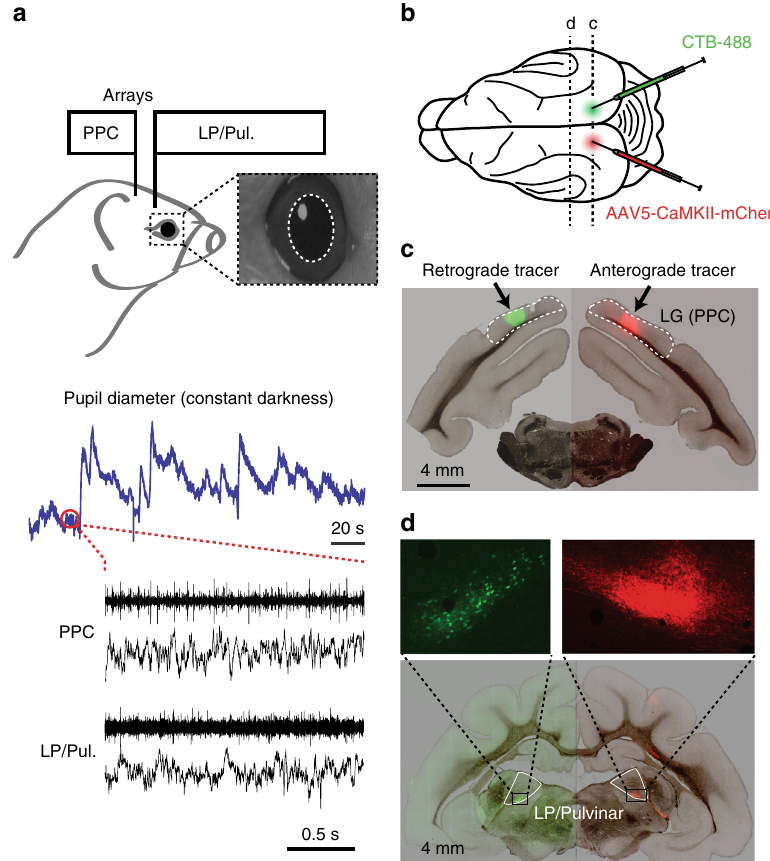
Fig. 1 Experimental setup and anatomical connectivity between LP/Pulvinar and PPC. a Diagram illustrating how neural signals from PPC and LP/Pulvinar were simultaneously recorded with pupil diameter. Inset image shows a typical view of the ferret infrared eye tracking, with the pupil outlined in white. Below are raw traces of ongoing fl uctuations pupil diameter and co-recorded spiking and LFP activity in PPC and LP/Pulvinar. Note that pupil diameter spontaneously fl uctuates on both short and long timescales. b Anterograde (rAAV5-CaMKII-mCherry) and retrograde (CTB-488) tracers were injected into PPC in the left and right hemispheres, respectively. c Bright fi eld image of a brain section containing the PPC injection sites overlaid with green and red fl uorescence channels. Fluorescent blobs show the location of anterograde and retrograde tracer in PPC. d Bright fi eld image of thalamus overlaid with fl uorescence from red and green channels. Retrograde labeling of cell bodies (green) and anterograde labeling of axonal projections (red) in corresponding locations of LP/Pulvinar illustrate reciprocal connectivity between PPC and LP/Pulvinar in the ferret. LG lateral gyrus, PPC posterior parietal